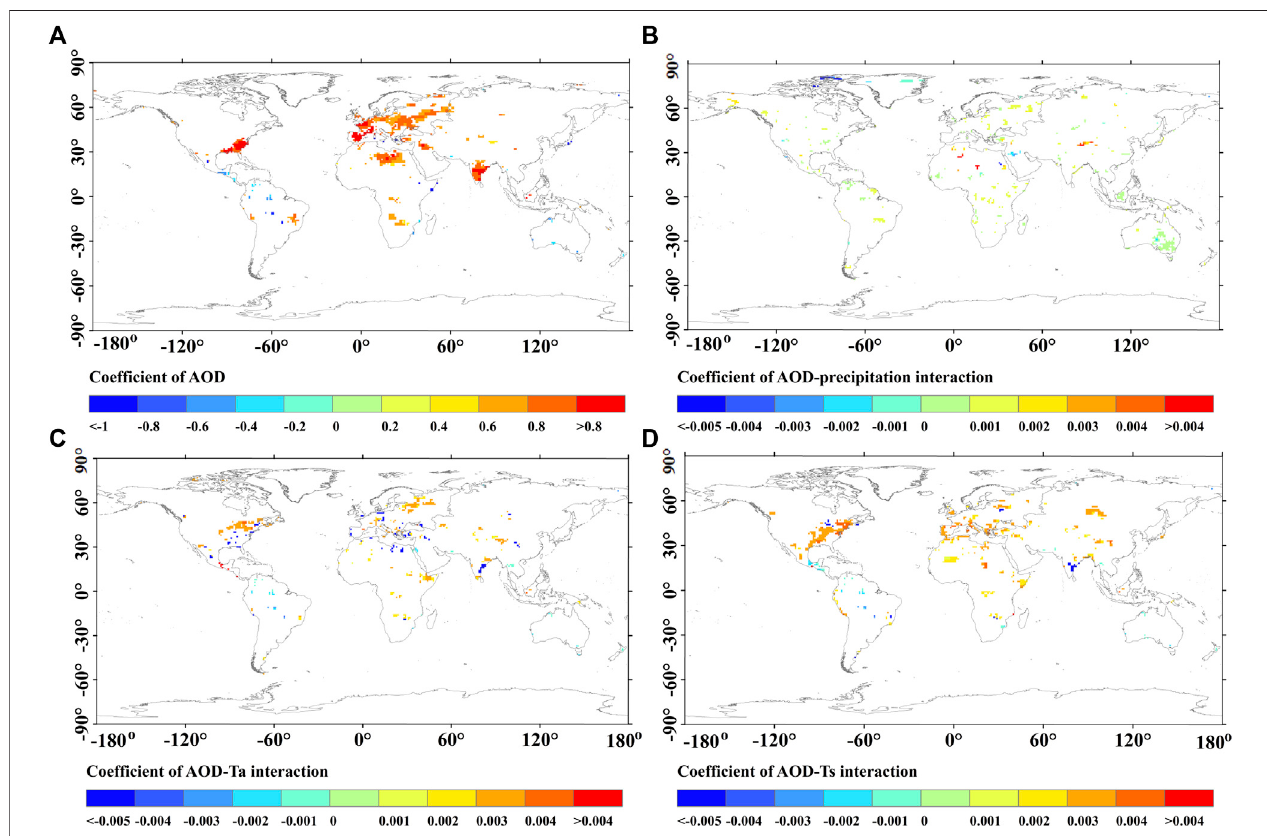
FIGURE 2 | Coef fi cients of (A) initial aerosol and (B) precipitation (C) Ta and (D) Ts. The blank regions indicate that the variables do not enter the stepwise MLR model and therefore suggest nonsigni fi cant changes in aerosols.